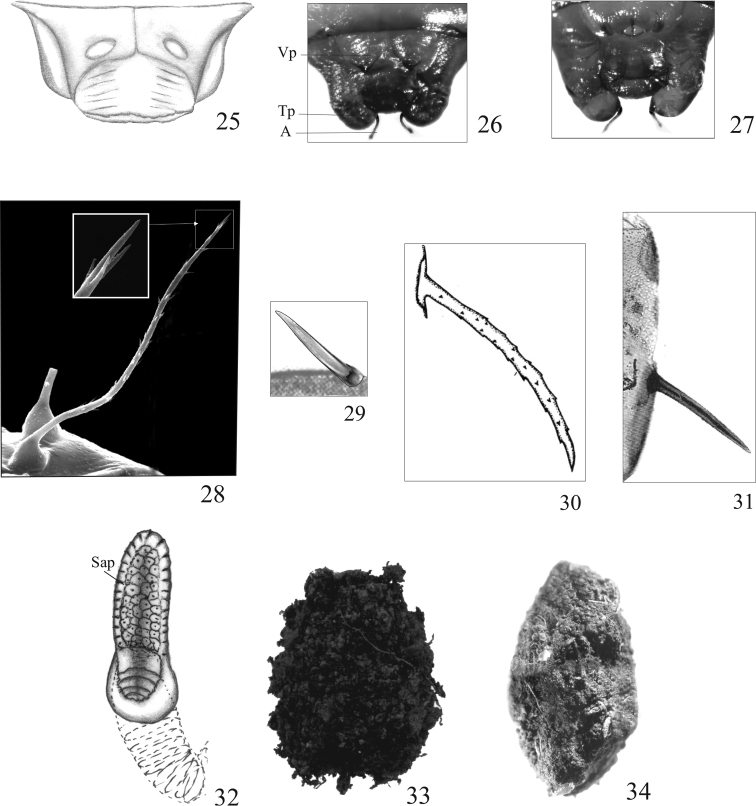
Pupae; terminal sternites (25–27), setiform projection of pronotum (28), spine of pronotum (29), spine of abdomen (30, 31), functional spiracle (32). Cocoon (33, 34) 25Ontholestes
murinus, female 26, 27Staphylinus
erythropterus, female (26), male (27) 28Gabrius
appendiculatus29Quedius
cinctus30Quedionuchus
plagiatus31Quedius
cinctus32Atanygnathus
terminalis, III pair 33Ontholestes
murinus34Rabigus
tenuis. Abbreviations: A accessory, S spine, Sap spiracular appendage, Tp terminal prolongation, Vp ventral prolongation.